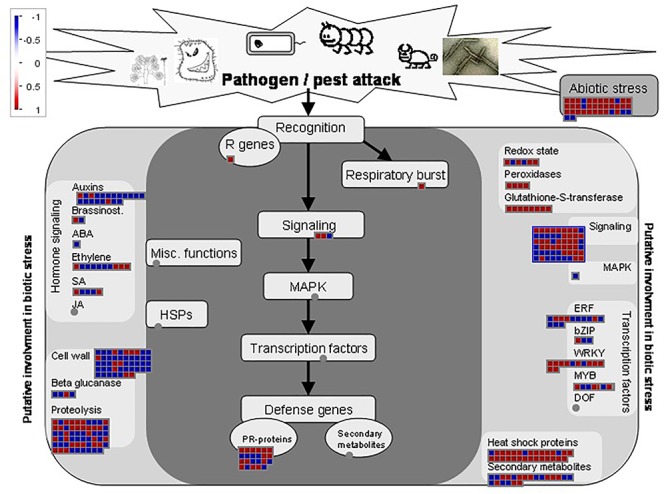
Biotic stress overview pathway for FRh2-inoculated plants DEGs as generated by MapMan software. Red and blue boxes represent up and downregulated genes, respectively. Colour intensity represents the degree of expression given as log2 fold change >1 and <–1.